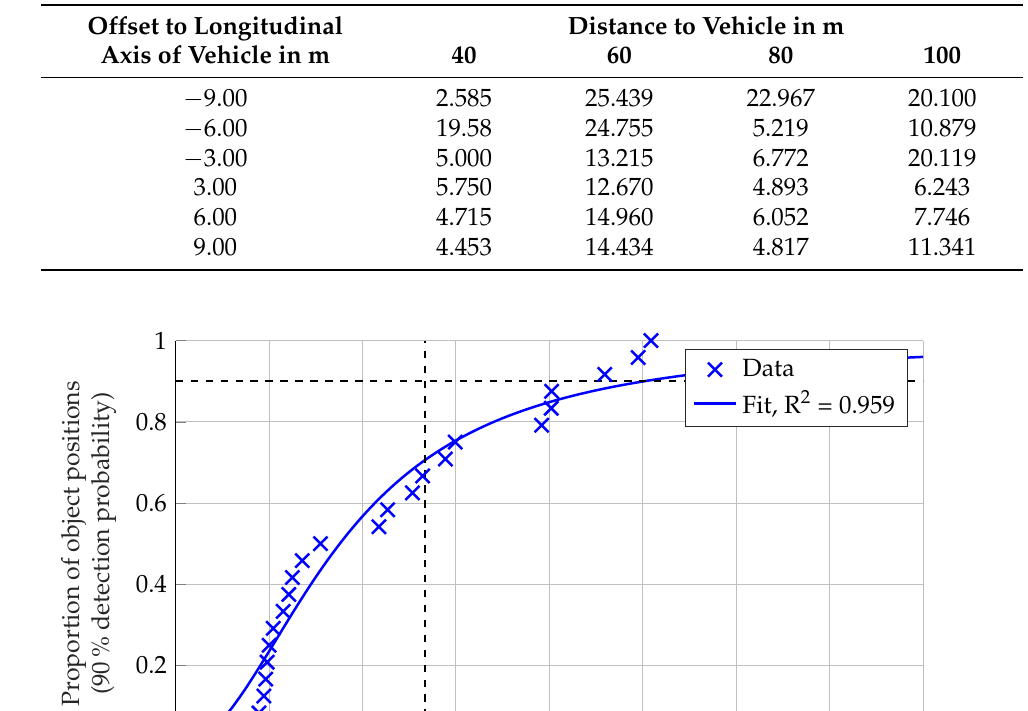
Table 4. Required Visibility Level on the different object positions on the closed test site.